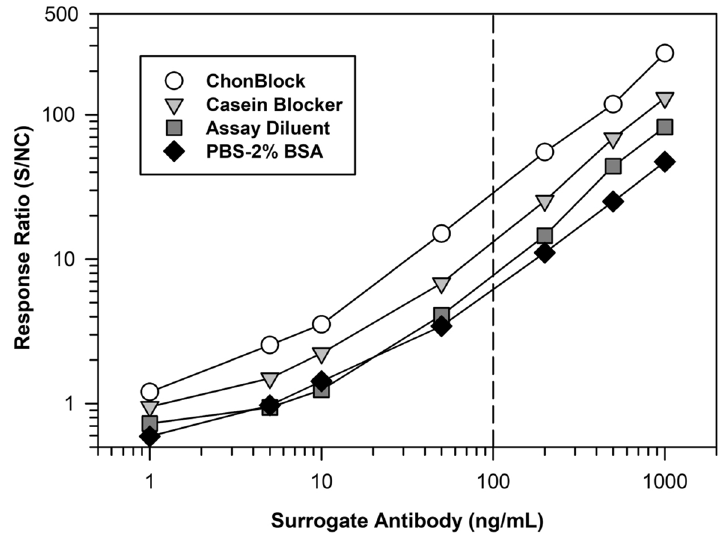
Figure 3. Sensitivity comparison of the optimal blocker-diluents for detection of serum ADA. On day 1 the MSD plate was coated overnight at 4 °C with 2 µg/mL of a representative biotherapeutic. On day 2, the plate was washed and blocked with the various candidate blocker-diluents. A standard curve of a surrogate specific rabbit antibody was prepared in human serum and then diluted 1/100 in the various buffers. The assay was performed, as described in the “Materials and methods” section, using detection with 0.1 µg/mL of SULFO-TAG labeled Protein-A/G diluted in LowCross Buffer. The reported response ratio is the RLU of the surrogate